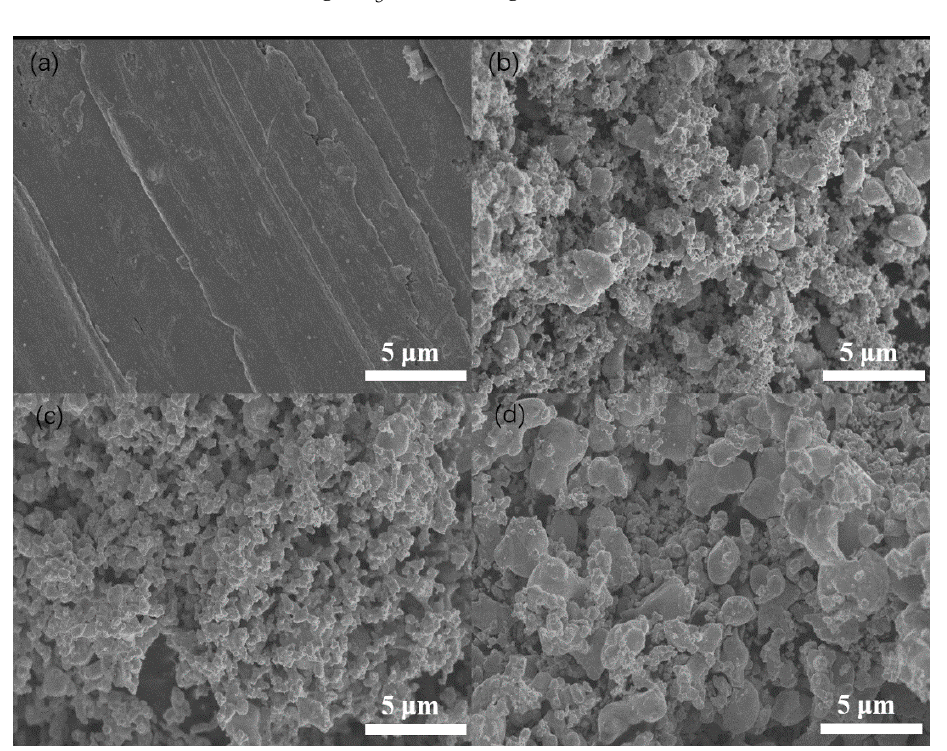
Figure 2. SEM images of Ag materials: ( a ) Ag foil; ( b ) 10 CD-Ag; ( c ) 15 CD-Ag; ( d ) 20 CD-Ag. According to the loading amount of Ag and Formula (1), the theoretical mass losses of 10 Ag/CM, 15 Ag/CM, and 20 Ag/CM due to the reduction of AgNO 3 by CM are 6.5%, 9.3%, and 12.3%, respectively. Except for 20 Ag/CM, the theoretical mass losses of 10 Ag/CM and 15 Ag/CM are consistent with experimental data at the first step below 250 ◦ C. Therefore, the first mass loss step can be assigned to the reduction of AgNO 3 particles by CM, while the second one above 250 ◦ C should be related to the burn-off of CM. For 20 Ag/CM, the difference between the theoretical and experimental values indicates that the AgNO 3 particles cannot be fully reduced in the first step arising from the thick AgNO 3 shell, weakening the reduction effectiveness of CM. This also means the reduction of residual AgNO 3 particles could take place together with the burning-off of CM in the second mass loss step. At high temperatures, many factors, such as the rapid reduction of residual AgNO 3 particles, the disappearing confinement of CM, and the heat released from combustion, could result in the metallic Ag particles sintering and their growth in different degrees, along with different pore formations. As for 15 Ag/CM, the AgNO 3 particles can be fully reduced at low temperatures. The confinement of pores and surface functional groups of CM is in favor of dispersing and stabilizing the reduced Ag particles. In the second stage, the combustion temperature of CM increases in accordance with the order of 15 Ag/CM, 20 Ag/CM, and 10 Ag/CM, depending on the different activity of Ag species for CM combustion. In any case, the low-temperature combustion of CM can inhibit the growth of Ag particles and damage pore channels easier. These functions result in the formation of small Ag particles and uniform pore size on 15 CD-Ag. The existence of a small amount of big Ag particles and pores on 10 CD-Ag is mainly attributed to the high-temperature removal of CM. For 20 CD-Ag, the formation of a large amount of big Ag particles and pores should be related to the rapid reduction of residual AgNO 3 particles along with the high-temperature removal of CM, which accelerates agglomeration,